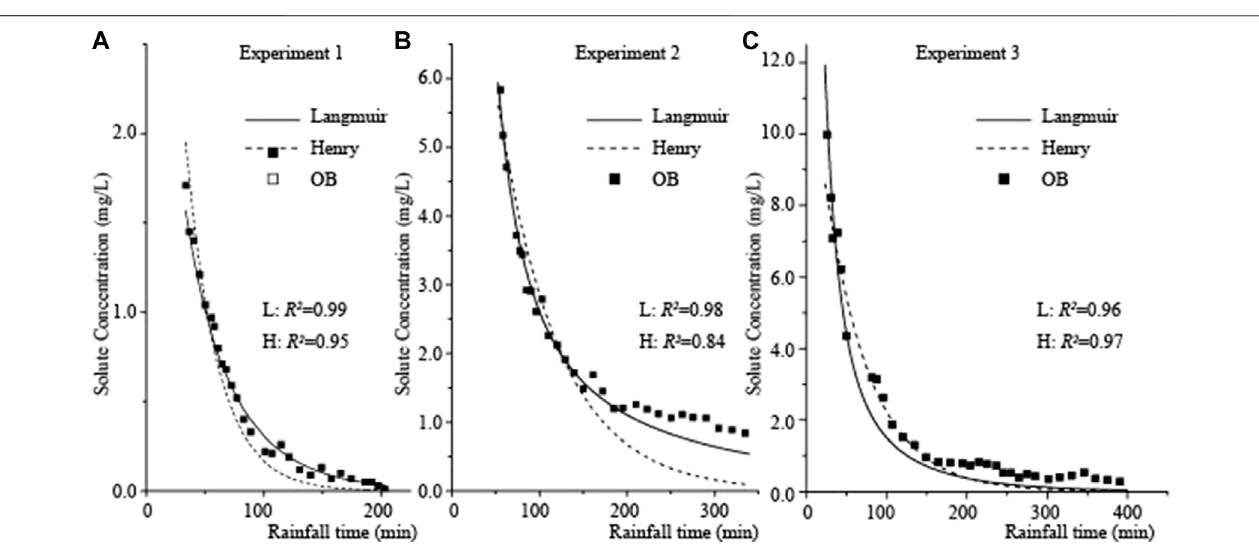
FIGURE 4 | Comparison of experimental data and optimized models within Langmuir and Henry equation. Note: OB was for the Observation